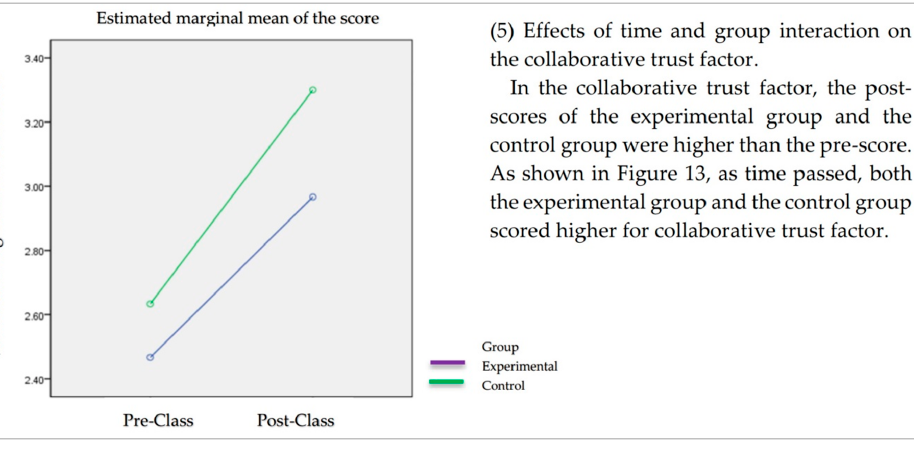
Figure 13. Effect of timing and group interaction on Trust.